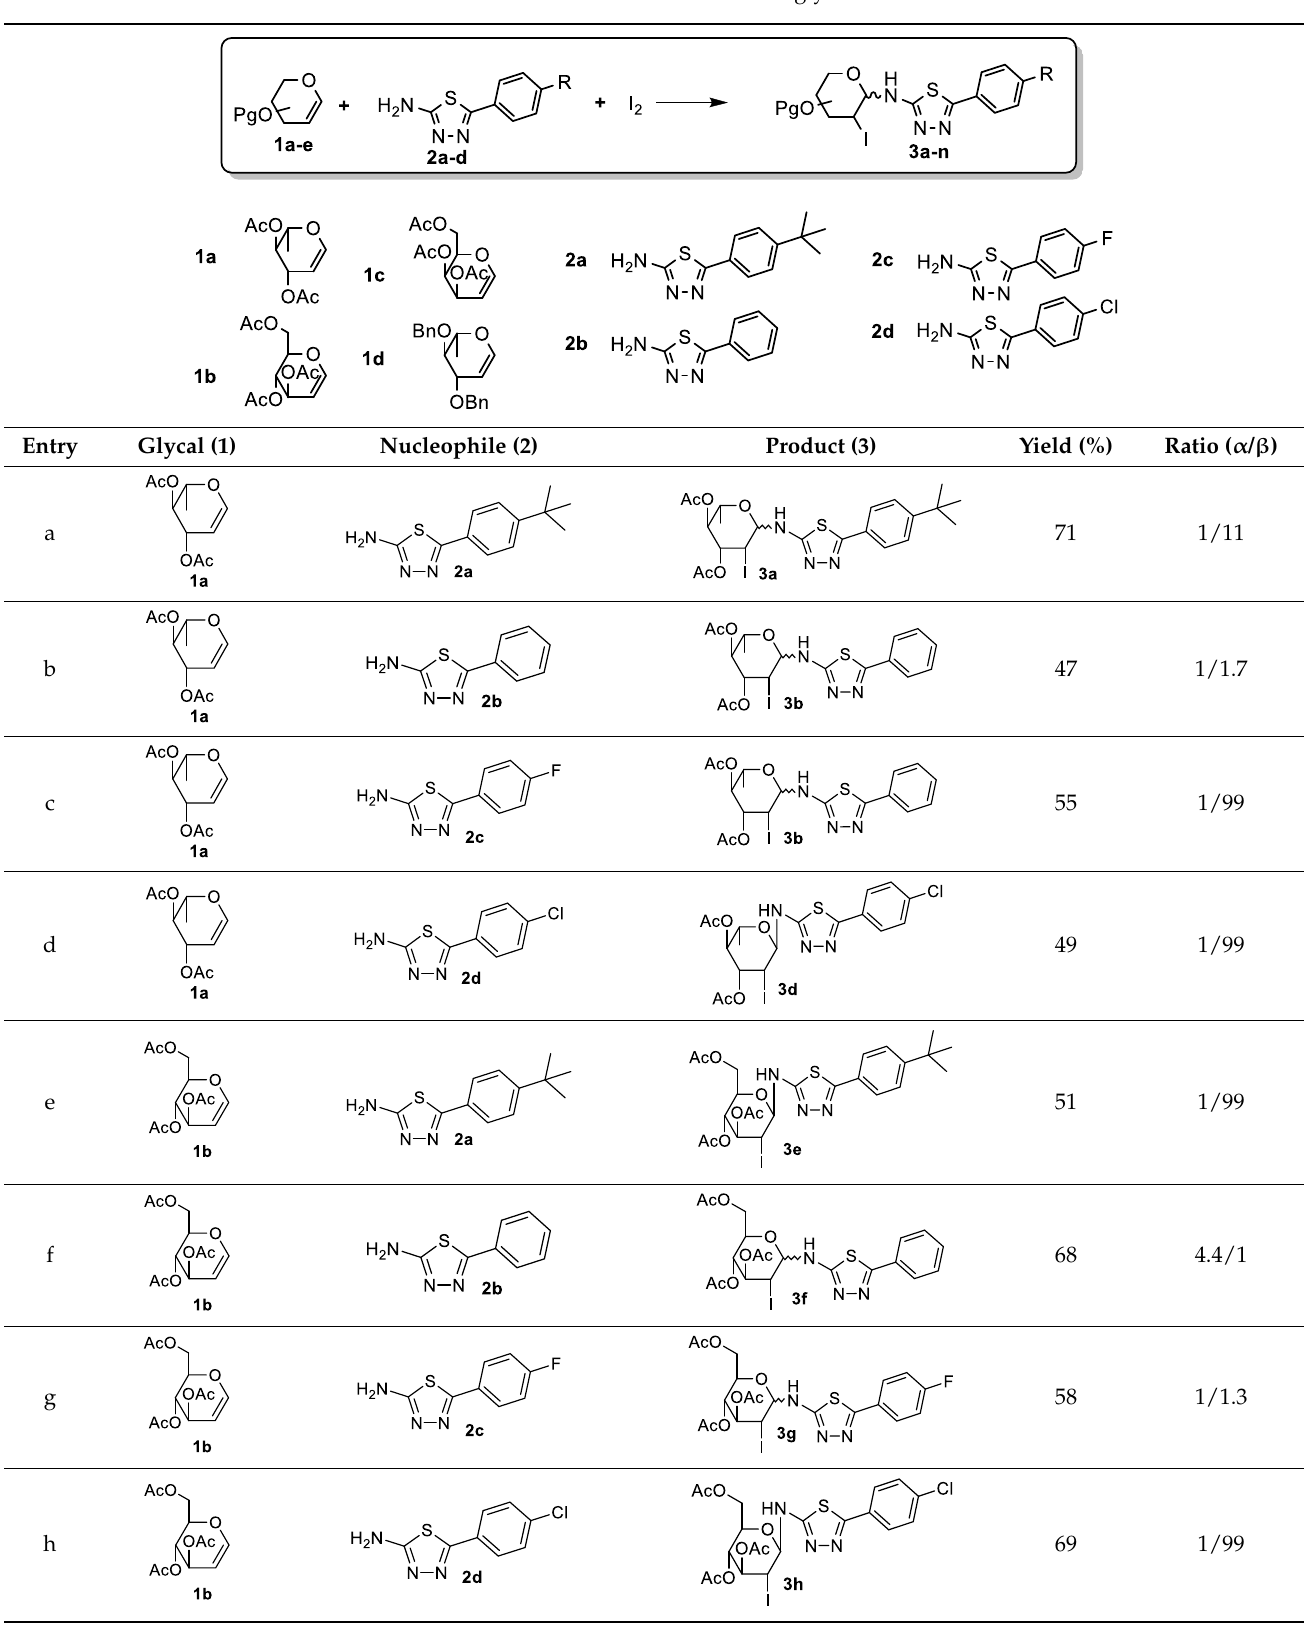
Table 2. Iodoamination of selected glycals.